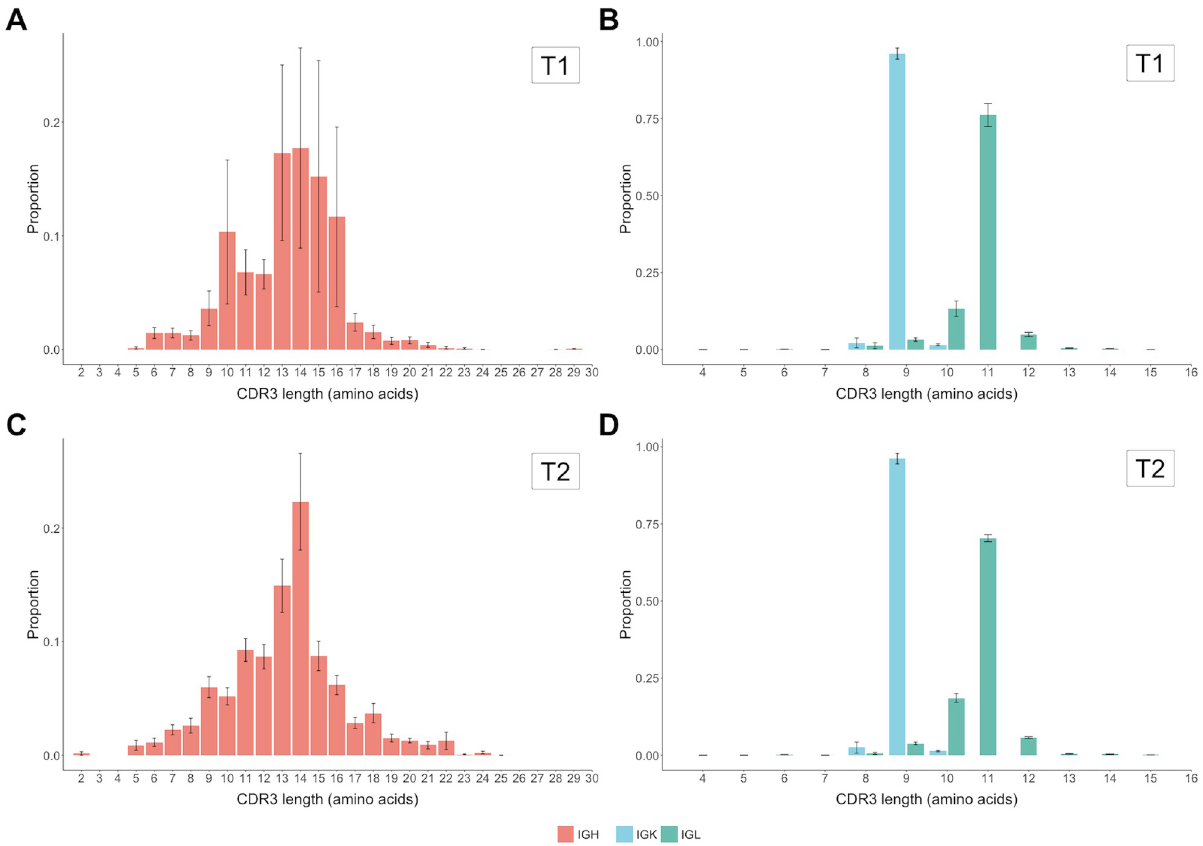
Fig 11. Heavy and light chain CDR3 lengths of cases at T1 and T2. CDR3H amino acid length from case individuals at T1 (A) and T2 (B). Light chain CDR3 lengths from case individuals at T1 (C) and at T2 (D). Distribution of functional clone size was calculated as the average proportion of functional clones for each observed CDR3 length at each time point. CDR3 length is defined from position 105 to 117 without the conserved cysteine of FR3 nor the first tryptophan/phenylalanine of